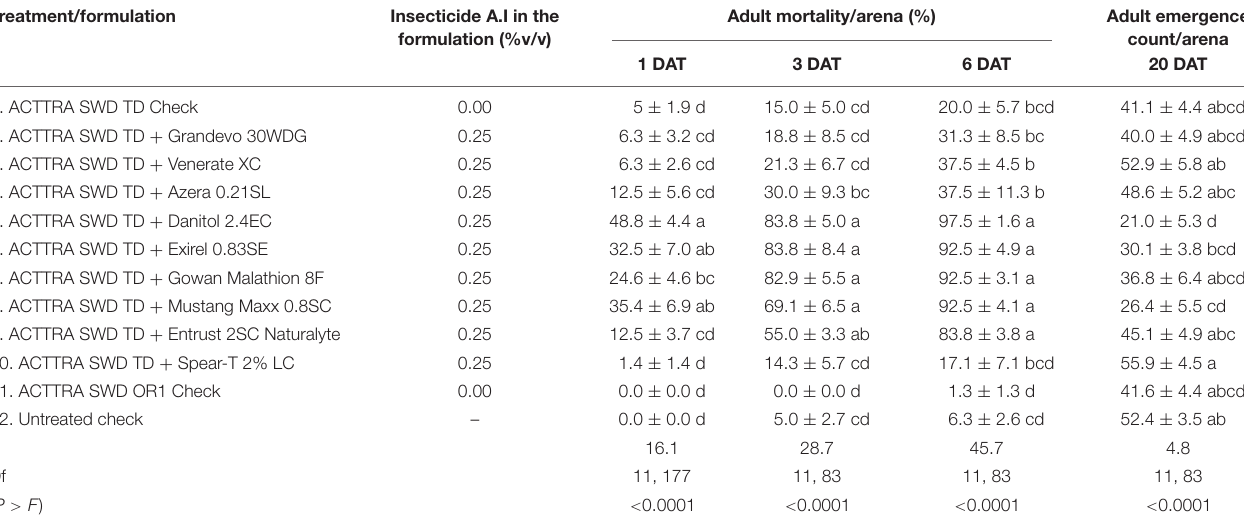
TABLE 3 | Percent adult Drosophila suzukii mortality (mean ± SEM), 1, 3, and 6 days after exposing the insects to various ACTTRA SWD TD + insecticide formulations and controls treatments and the mean ( ± SEM) counts of adult D. suzukii emerged 20 DAT, from the blueberries incubated from the bioassay arena.